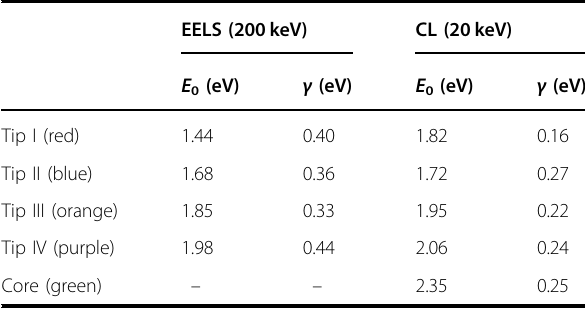
Table. 1 Fitted plasmon resonance energies ( E 0 ) and FWHM linewidths ( γ ) derived from the EELS and CL data (Fig. 2a,